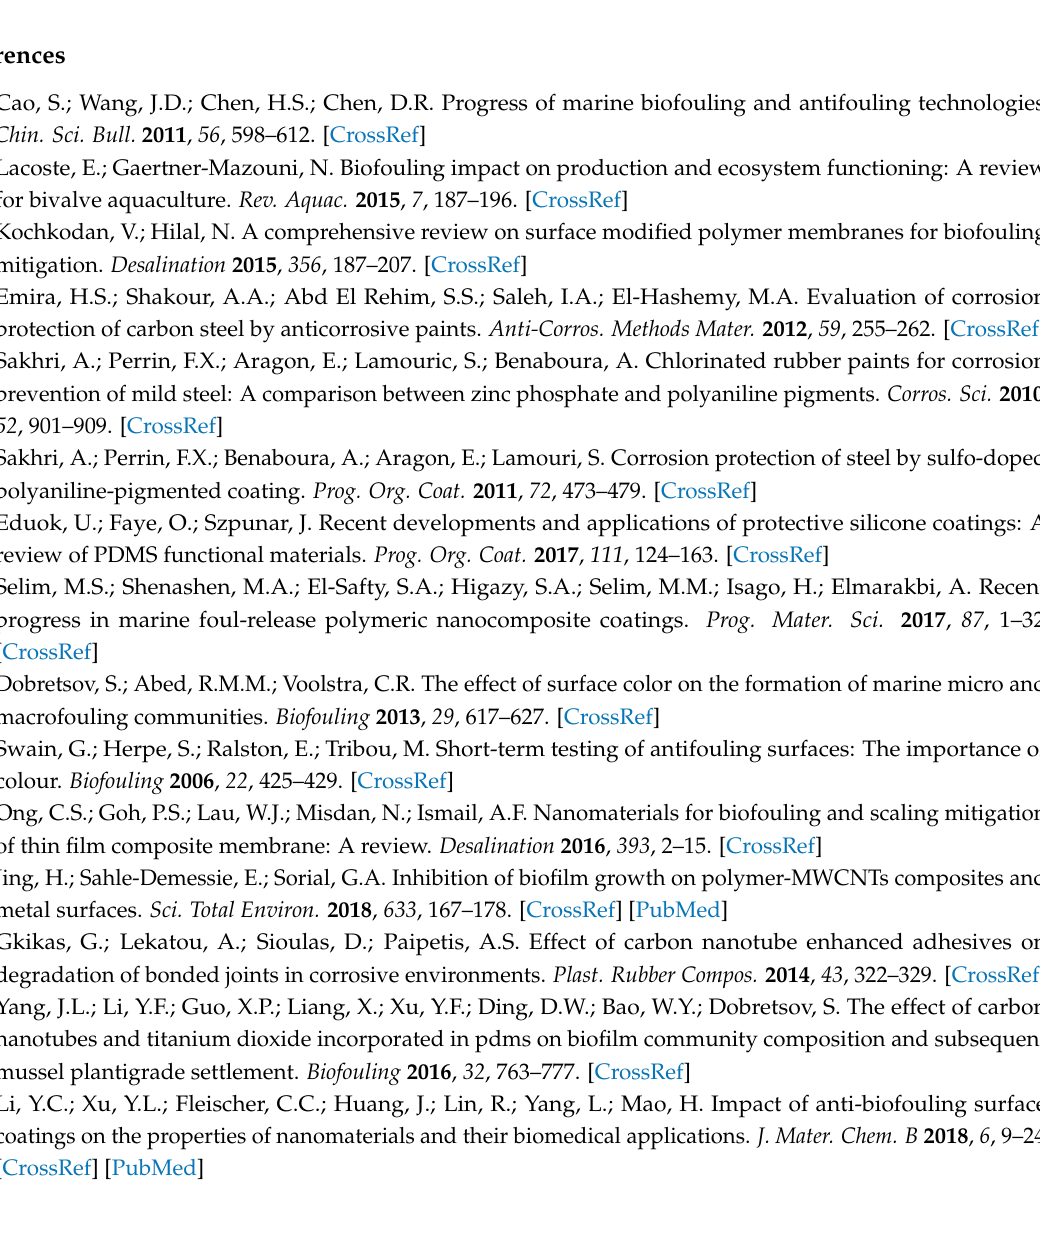
Figure S1: Layout of biofilm samples from different protective